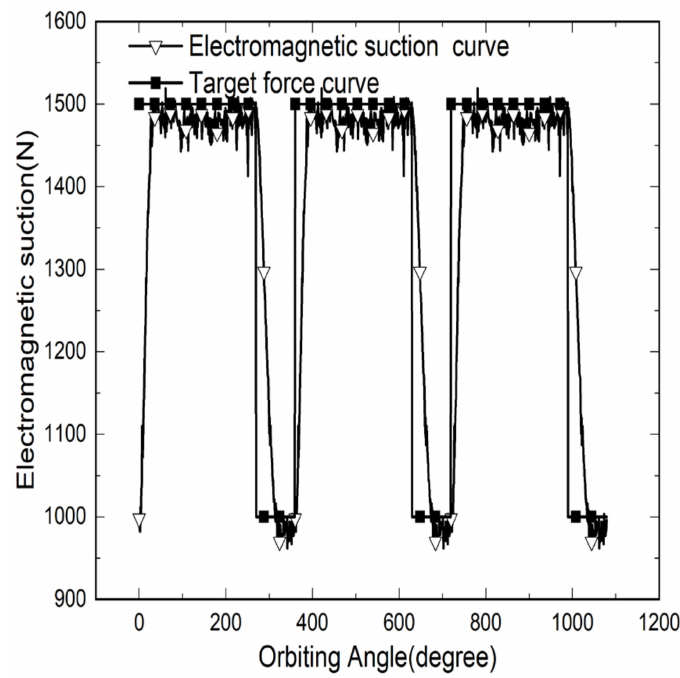
Figure 10. Tracking the electromagnetic force output of a square wave